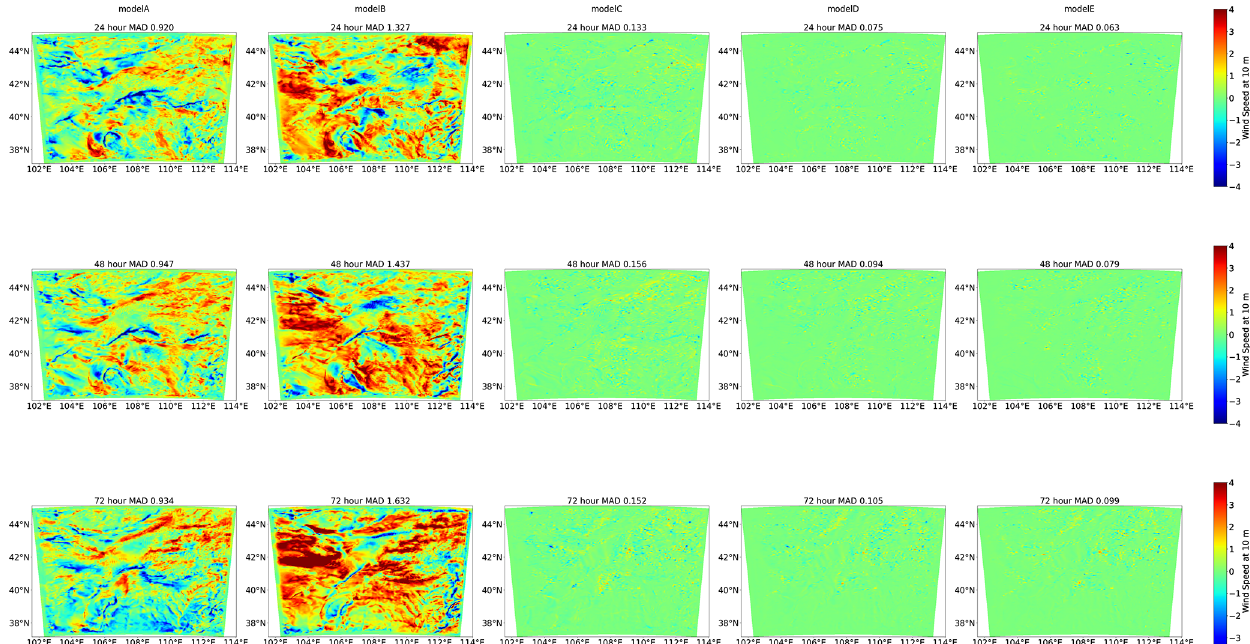
Figure 7. Differences in temperature at 2m at forecast horizons of 24, 48, and 72h between WRF simulations coupled with ML models A, B, C, D, and E and the WRF simulation with the original RRTMG schemes for radiation emulation. The title of each figure indicates the mean absolute difference (MAD) of the WRF domain.